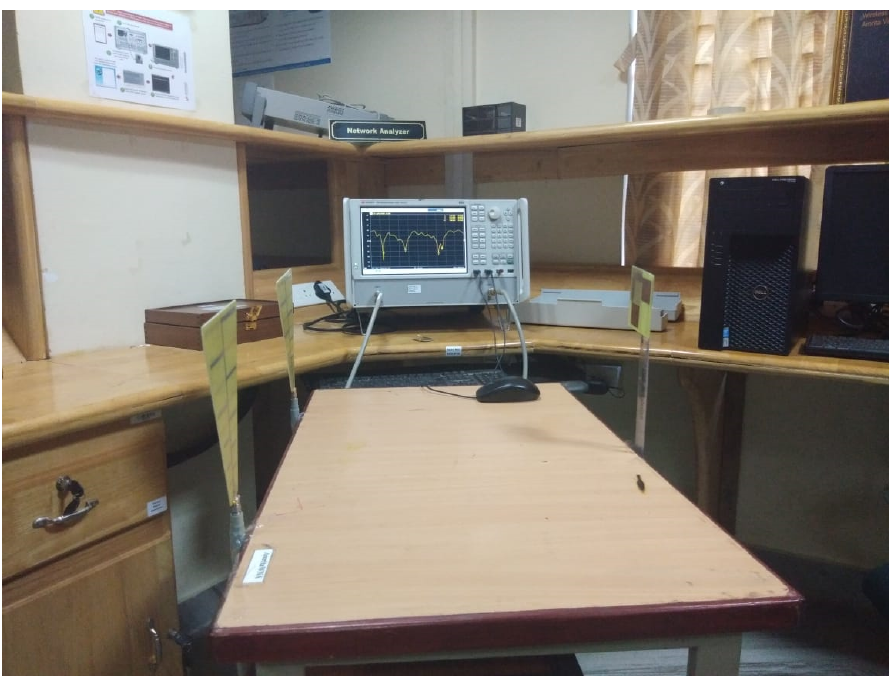
Figure 7. Measurement setup of passive 4 bits CSR tag.